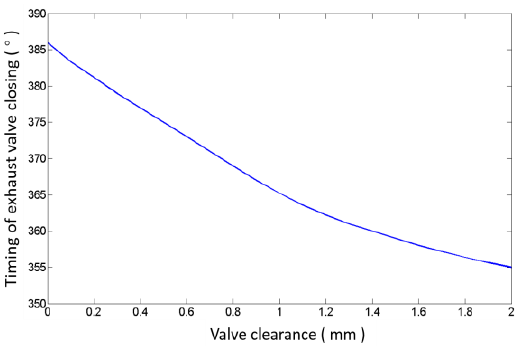
Figure 6. The relationship between valve clearance and the timing of valve closing.